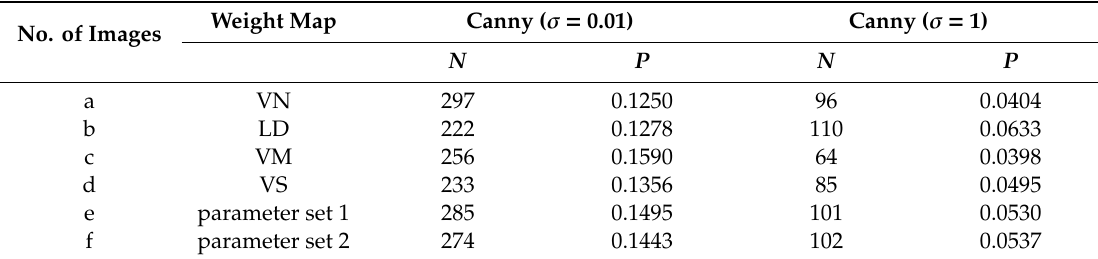
Table 4. Evaluations of fusion e ff ects in Figure 6.